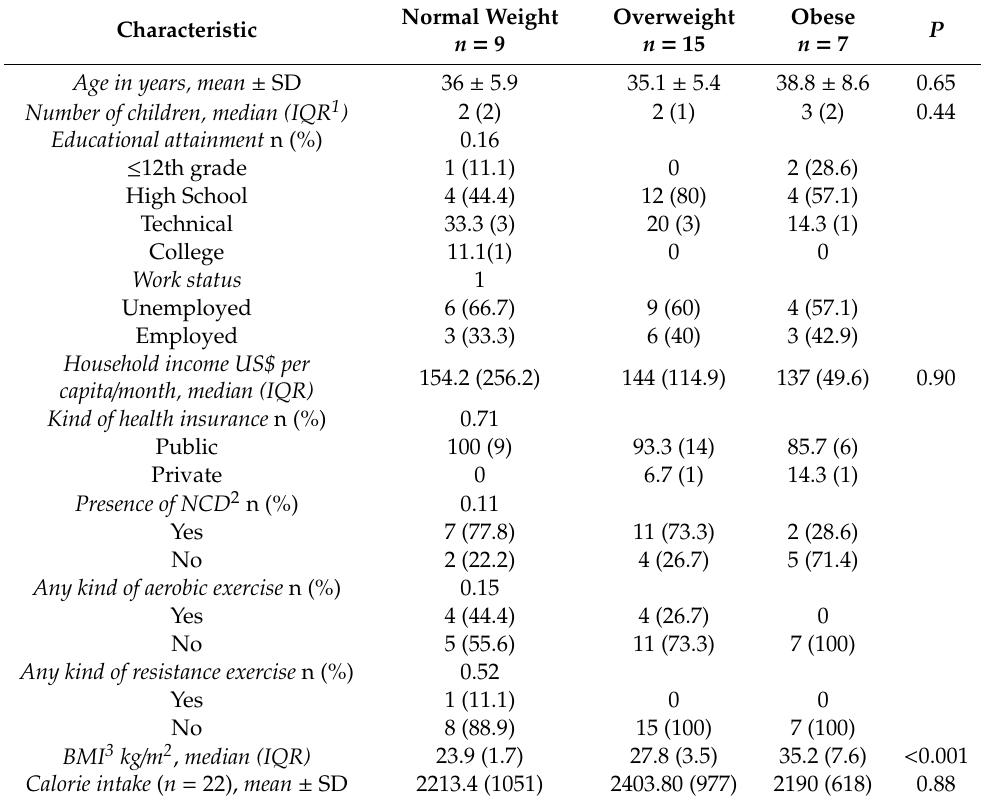
Table 1. General characteristics of participants by weight status ( n =